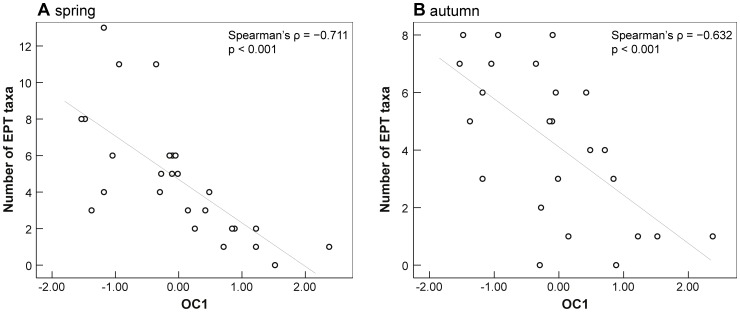
Number of EPT taxa (Ephemeroptera, Plecoptera, Trichoptera) correlating with the first component of the PCA with organic contaminants (OC1).Displayed are results for sampling campaign in spring (A) and autumn (B). Please note different scaling of y-axes in A and B.